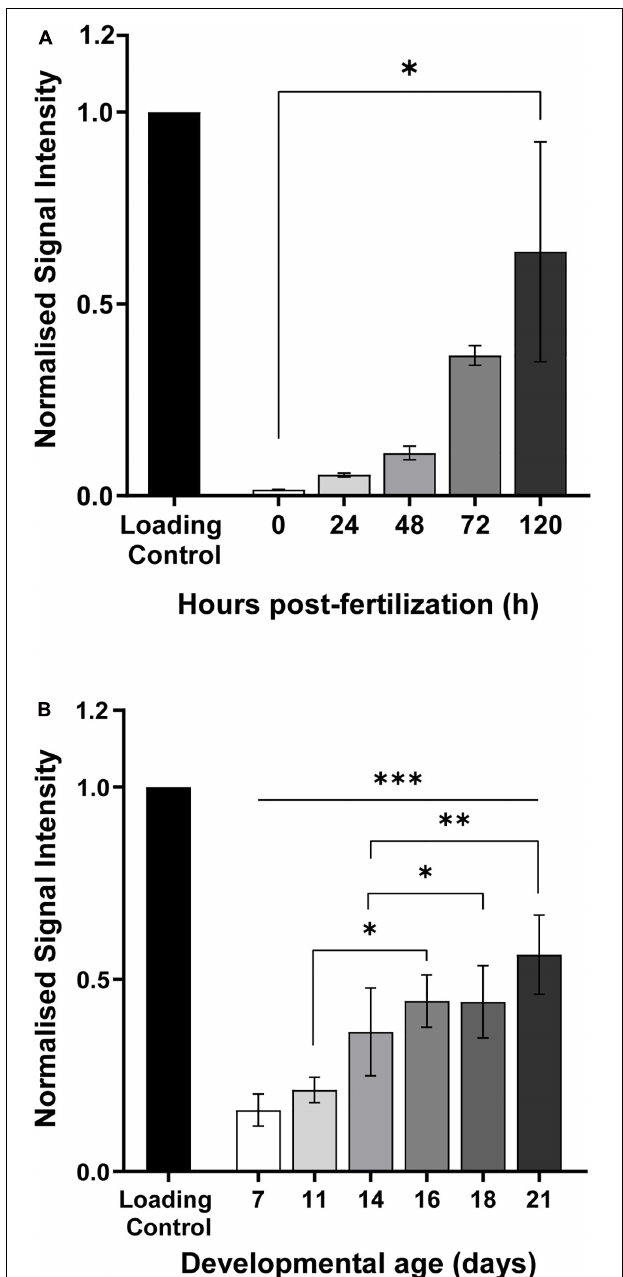
FIGURE 5 | Quantification of 6mA modification in genomic DNA extracted from (A) zebrafish and (B) mice, at different developmental stages. Later embryonic stages show a higher accumulation of this modification when comparing to the early stages. Data are from 20 to 100 biological replicates for zebrafish and 5 to 8 for mice, and presented as mean ± SEM. * p < 0.05; ** p = 0.001; *** p =